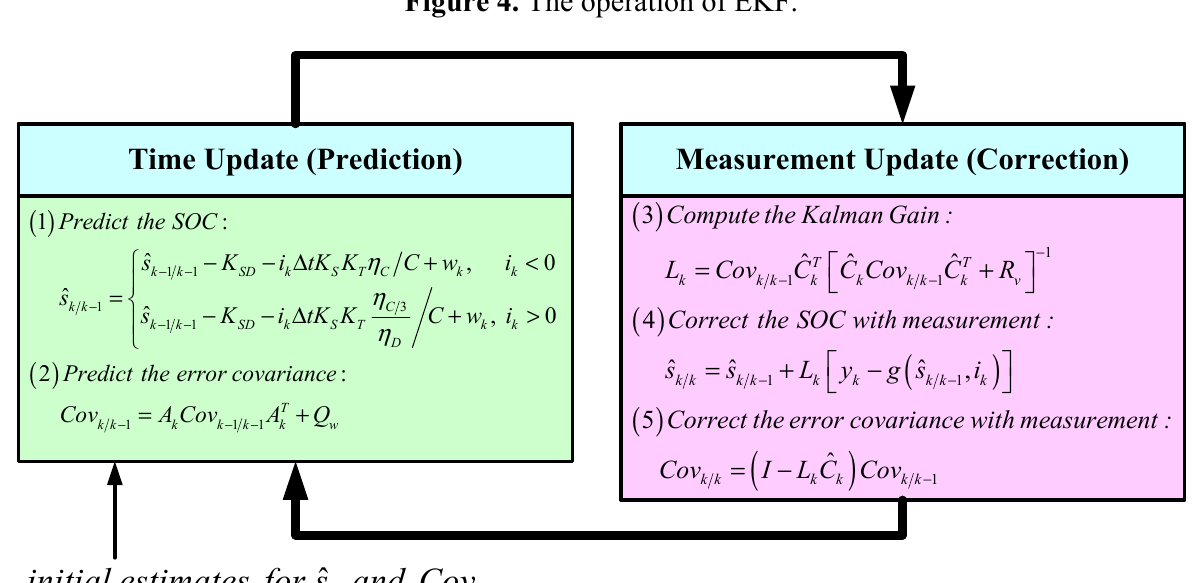
Figure 4. The operation of EKF.